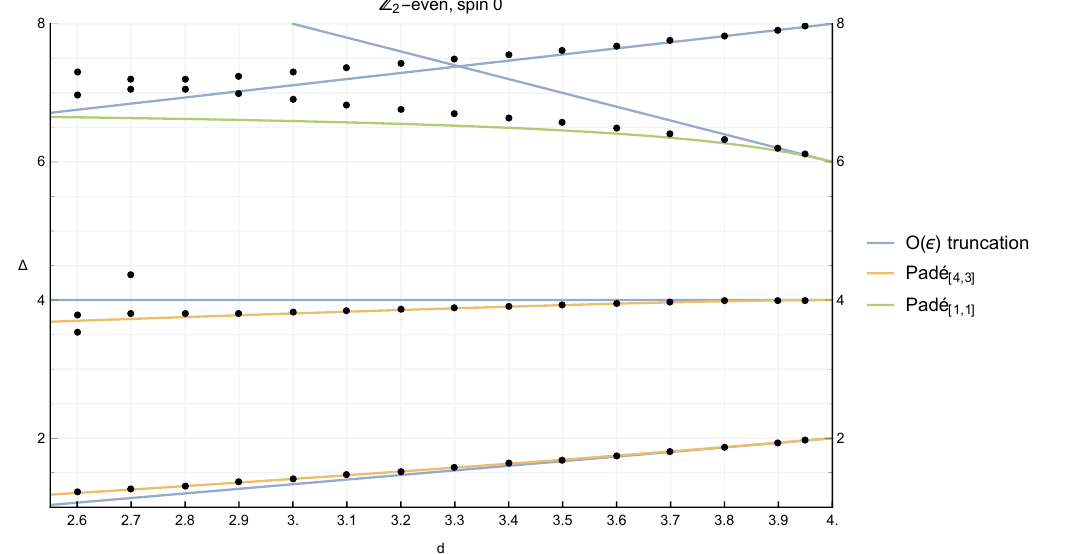
Figure 3 . Resummed perturbative estimates for the first four Z 2 -even scalar operators. For the fourth lowest operator, there are no results available beyond leading order in ε . The black dots indicate the spectrum found using the EFM at the navigator